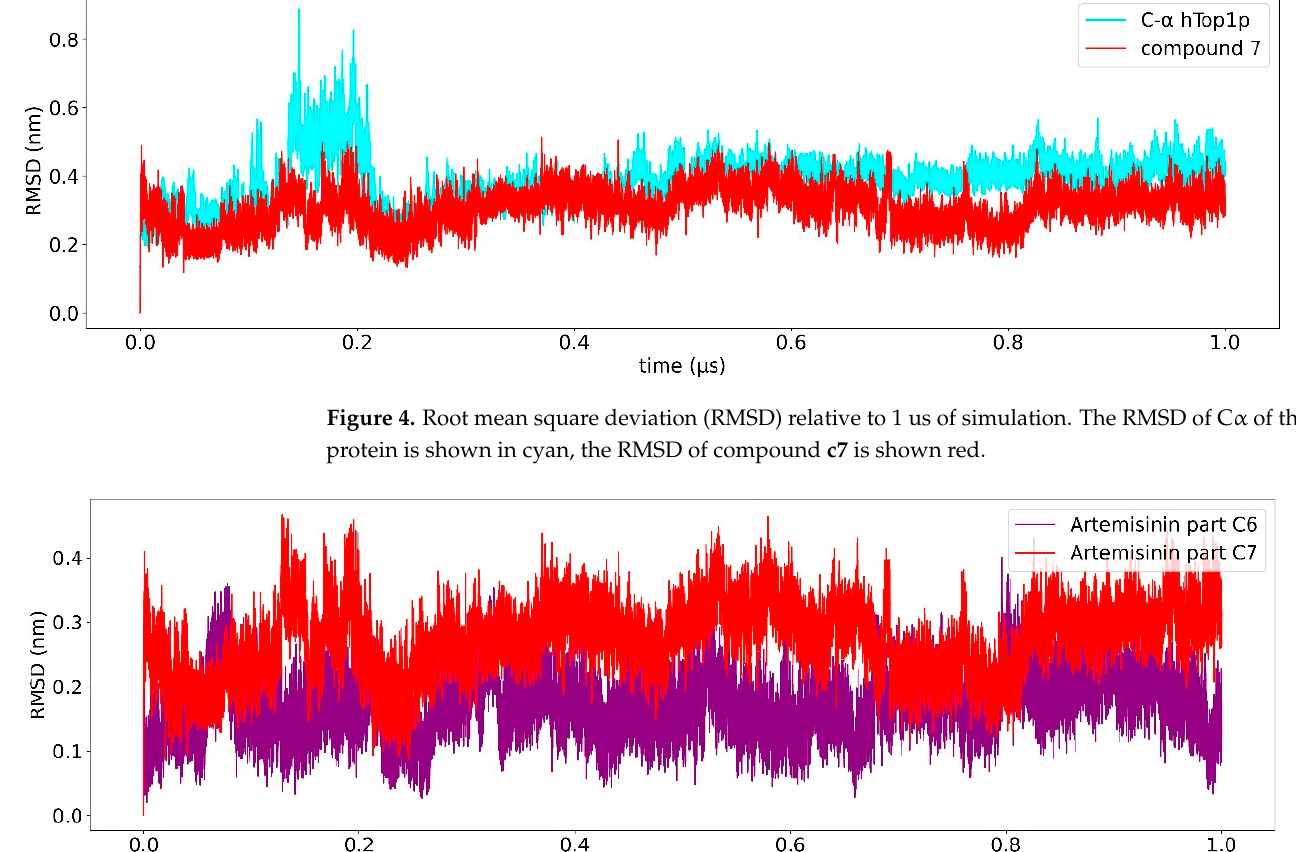
Figure 6. Root mean square deviation (RMSD) relative to 1 us of simulation. The RMSD of the ty- rosolic part of compound c6 is shown in purple, the tyrosolic part of compound c7 is shown in red. We also focused our attention on evaluating the flexibility of amino acid residues (RMSF) present in the core domain of hTop1p (amino acids 215 to 635), which are the main constituents of the binding site for the two compounds. High RMSF values indicate high flexibility of residuals during simulation. As shown in Figure 7, no significant difference is observed when comparing the RMSFs of the core domain of hTop1p as a whole with c6 (in purple) and with c7 (in red). In both cases, a high flexibility is found in the core domain region that extends from resi- due 310 to residue 340, while the remaining regions show controlled fluctuations during simulation. The RMSF of the core domain of hTop1p in the absence of ligands (in green) confirms the fluctuations observed for this domain in the presence of c6 and c7 , demon- strating that neither of the two derivatives of artesunate causes structural alterations.